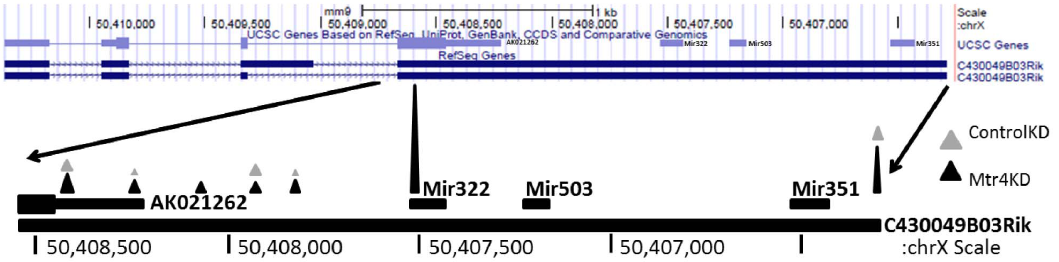
Figure 5. Abundant PA-seq reads map near mir322. The top diagram shows the mir322 - mir503 – mir351 cluster and associated RIKEN transcripts on chromosome X. Note that the chromosomal orientation has been reversed such that the mm9 chromosomal coordinates are in decreasing order from left to right because the transcripts are on the minus strand. The rightmost portion of this region has been expanded below to highlight both the location and relative abundance of adenylation in the mMtr4 KD (black) vs. mControl KD